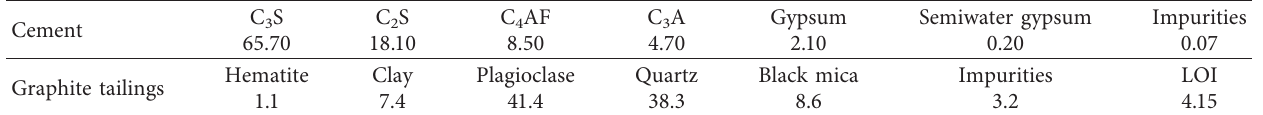
Table 3: Mineral content of cement and graphite tailings (%).